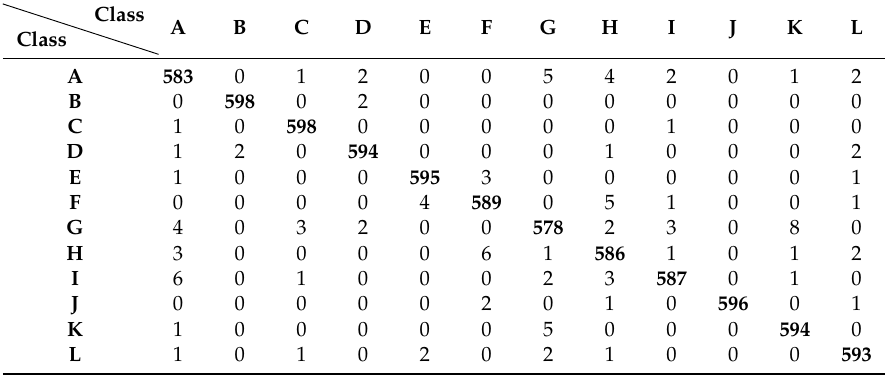
Table 15. Classification results using Logistic Regression secondary classifier.